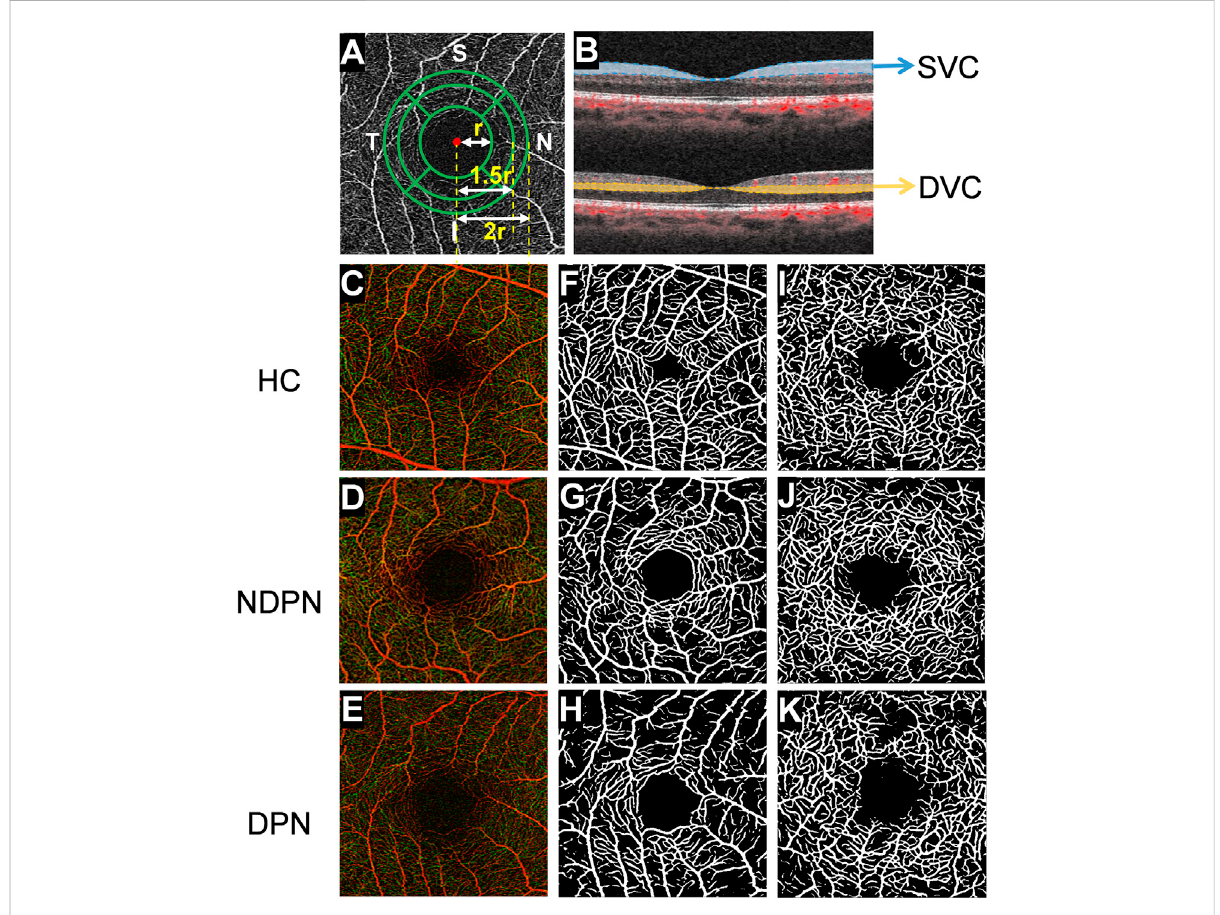
FIGURE 1 OCTA image analysis of macular fovea and arti fi cial intelligence algorithm for layered analysis of images. (A) Using OCTA to scan the macula area of the subject within the range of 3 × 3 mm 2 , and the images of capillaries around the fovea are obtained. Then, using deep learning software, FAZwasusedto fi tacirclewithradiusr,afterwhichthreeconcentriccircleswithradiusr,1.5r,and2rweredrawn.Withfurtherpartitioning,theretina was divided into inner and outer rings: nasal area, superior area, temporal area, and inferior area, and there were 8 areas in total. (B) The retina was segmented into SVC (from the internal limiting membrane to 10 μ m above the inner plexiform layer) and DVC (from 10 μ m above the inner plexiform layer to the 10 μ m below the outer plexiform layer) images with different depths. The images (C – K) show retinal microvascular in a different layer of HC, NDPN, and DPN groups. (C – E) The images show the full-thickness retinal microvasculature produced by OCTA in HC, NDPN, and DPN groups. (F – H) Capillaries in the SVC by deep learning software. (I – K) Capillaries in the DVC by deep learning